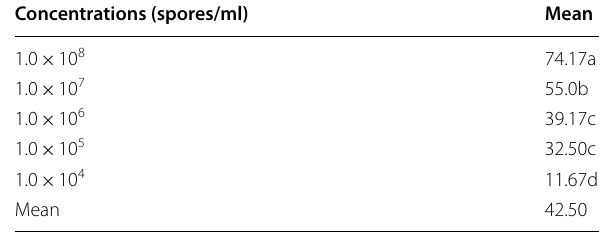
Table 3 Corrected mortality of Tuta absoluta larvae with different conidial concentrations in response to entomopathogenic fungi, Purpureocillium lilacinum , after seven days of treatment